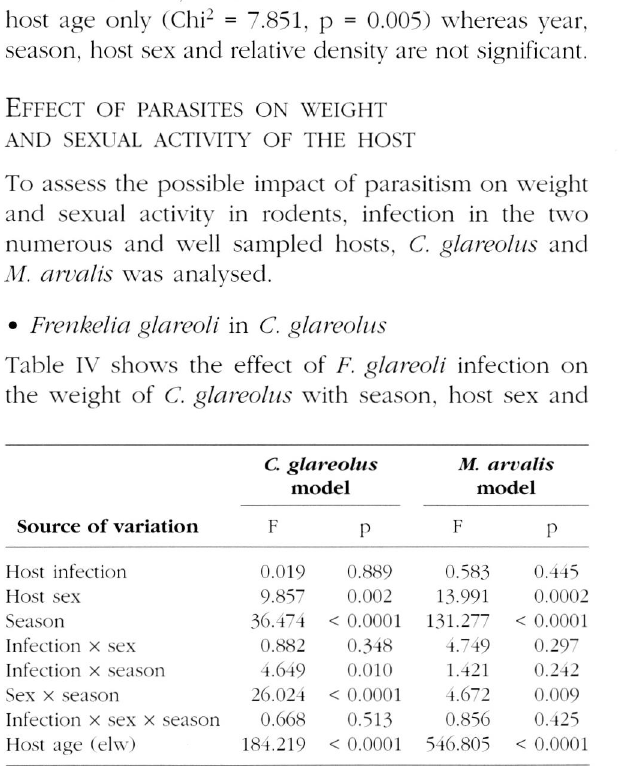
Table IV. - Intrinsic and extrinsic sources of variation in the body weight in Clelhrlonomys glareolus infected with Frenkelia glared! and in Microlus arratis infected with Frenkelia microti through ANCOVA. Host age. estimated by the eye lens weight (elw). is entered as a covariate in each